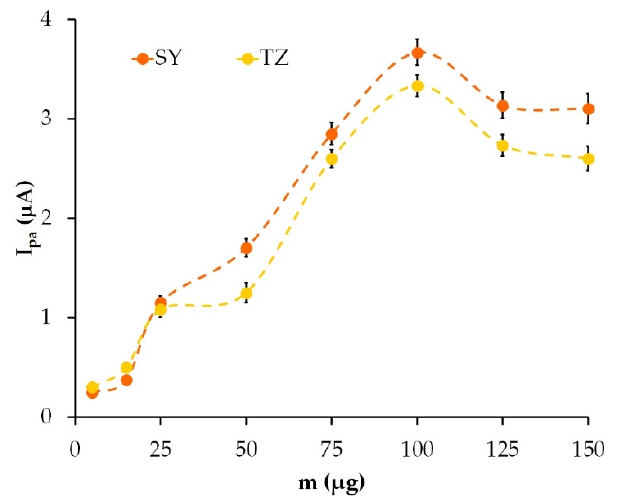
Figure 4. Dependence of oxidation peak current of 10 µ M SY and TZ on the quantity of graphite powder immobilized on the CP electrode.